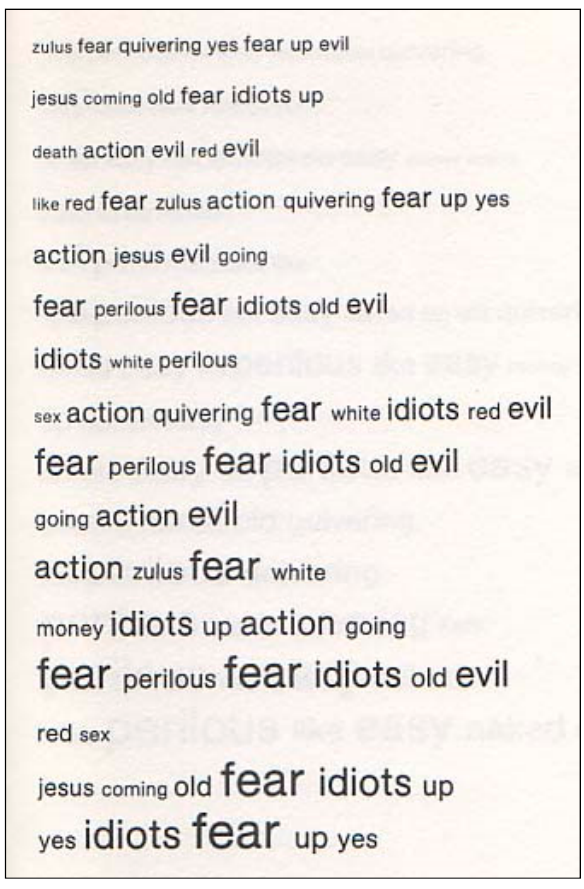
Figure 2. Emmett Williams. A Valentine for Noël . ([3], p. 33).